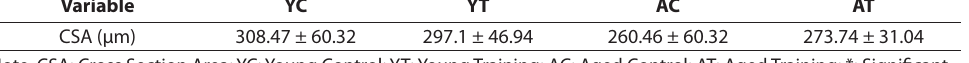
TABLE 6 Cross section area (CSA) of muscle